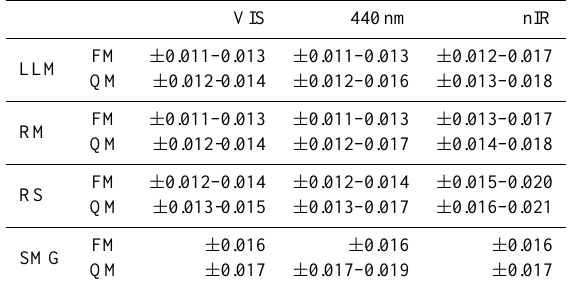
Table 3. Summary for night-time u AOD estimated values for visi- ble (VIS) and near-IR (nIR) channels considering the four different calibration techniques: Lunar Langley method (LLM), Ratio Moon (RM), Ratio Sun (RS) and Sun-Moon gain factor (SMG) methods. These results are presented for different moon illumination condi- tions: full moon (FM) and quarter moon (QM).